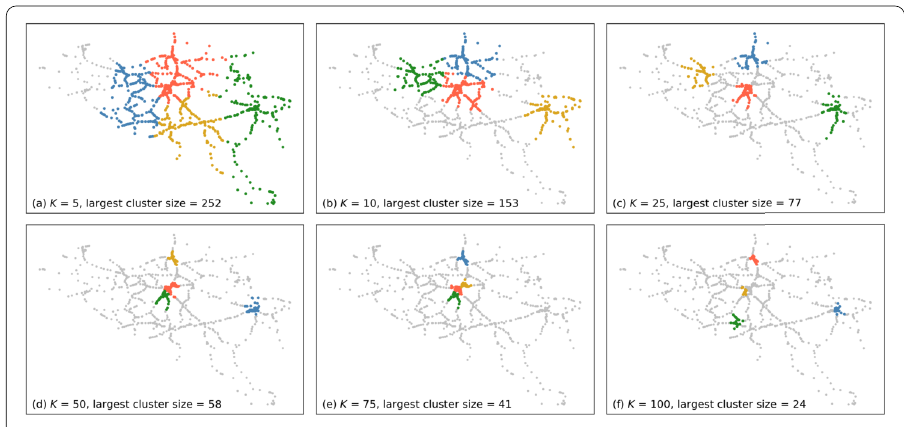
Figure 3 Clustering results for ( a ) K = 5, ( b ) K = 10, ( c ) K = 25, ( d ) K = 50, ( e ) K = 75 and ( f ) K = 100. For visibility purposes, only the fourth largest clusters are coloured (in the order of red, blue, green and yellow). Stations not belonging to any cluster are coloured grey. Cluster size is measured by amount of associated stations. Largest cluster sizes are denoted in panel